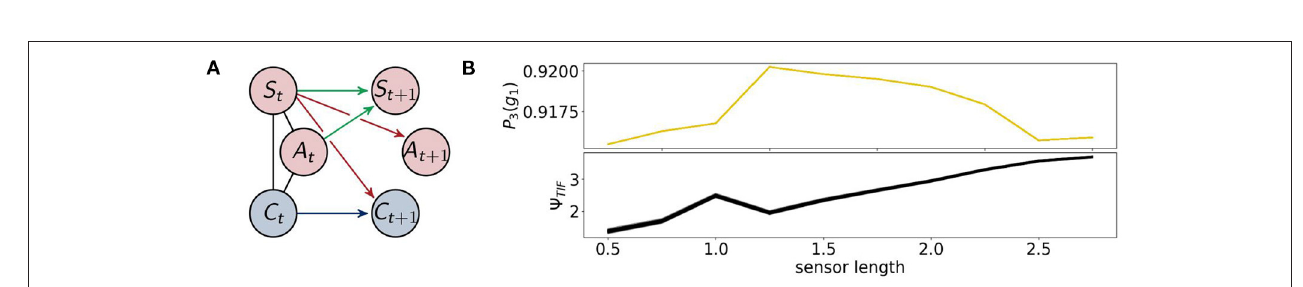
FIGURE 13 | (A) The architecture of the reactive control agents, (B) the probability of survival (top) and the total information flow 9 TIF (bottom).